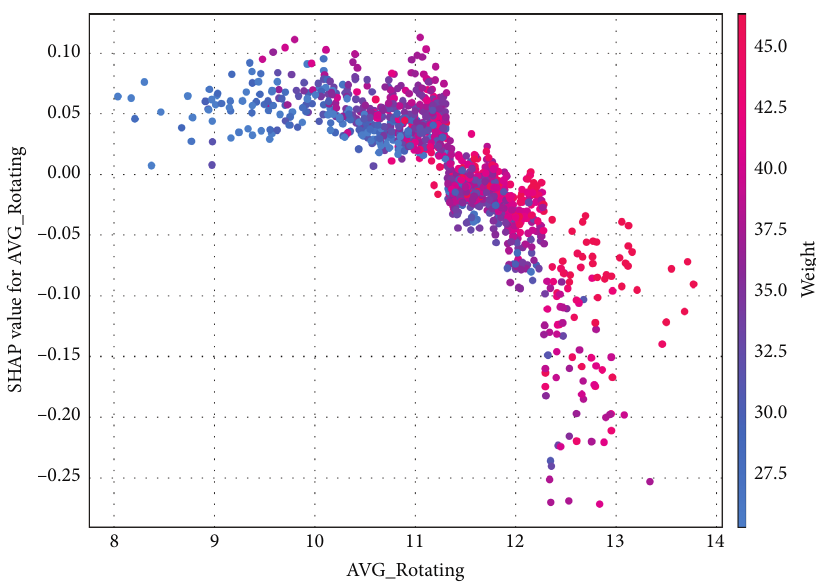
Figure 8: The global impact of average engine speed on fuel consumption.